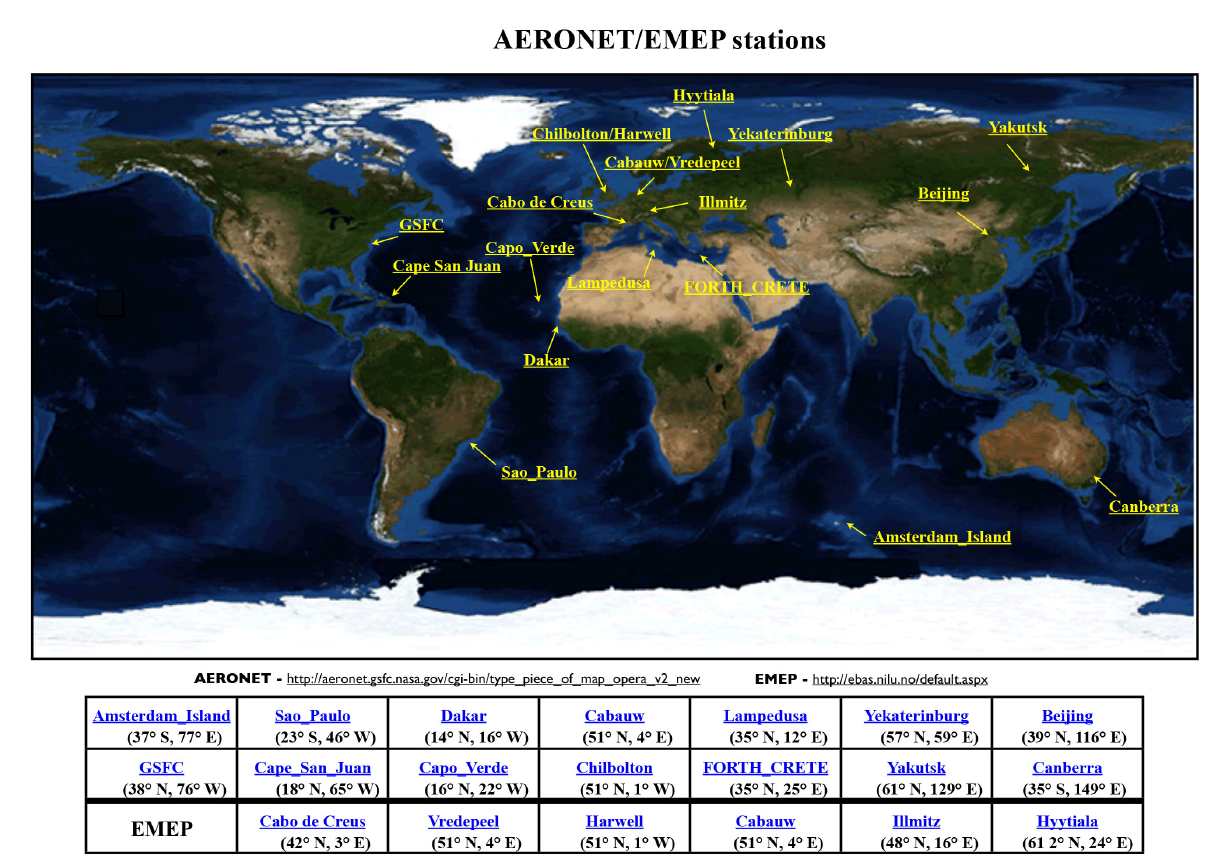
Figure 1. Locations of selected AERONET and EMEP stations used in this EMAC evaluation study. The corresponding regions are shown in Fig. S1